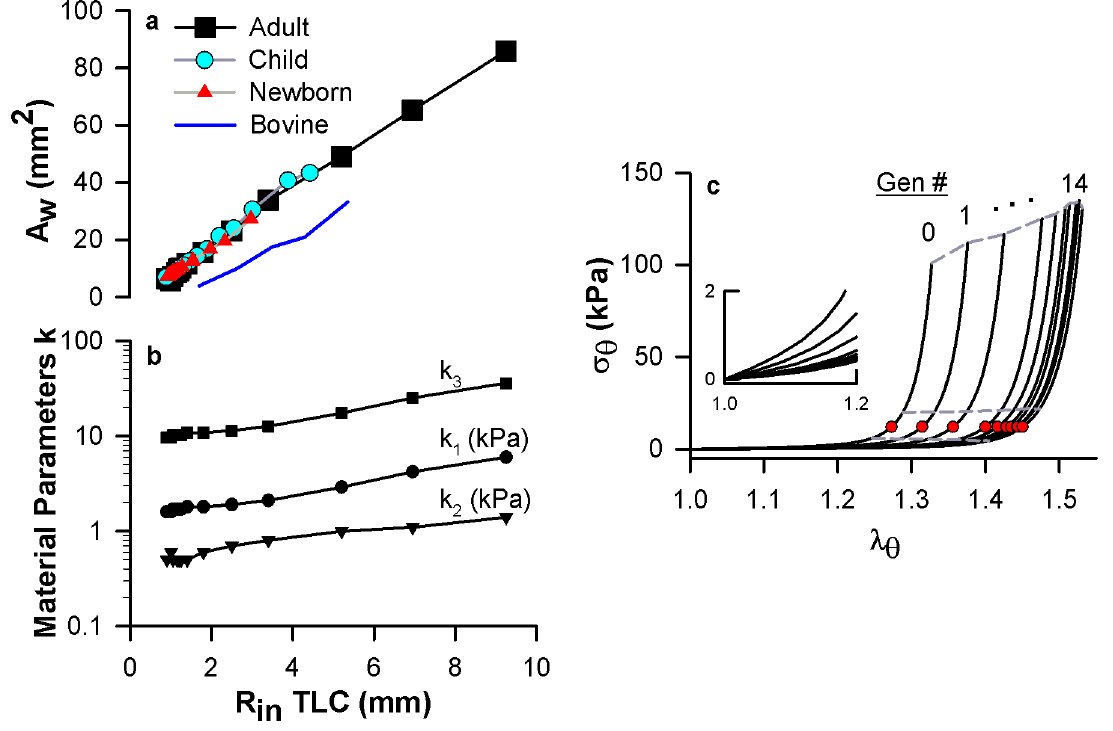
Figure 2. Mechanical homeostasis is maintained throughout the airway tree by a combined generation-dependence in wall dimensions and model-derived material parameters. a , Relationship between mean airway wall area (A w ) and mean luminal radius (R in TLC) for healthy humans obtained and reanalysed from the literature: newborns [15] (red triangles, 0 year old), children [15] (cyan circles, 3 years old), and adults [14] (black squares, mean age of 39.2 years old). The corresponding relationship for our bovine airways is shown in blue. Circles represent individual airway generations, where the largest radius in each data set corresponds to the trachea (generation 0). All dimensions are measured at total lung capacity (TLC, 2.5–3.0 kPa P TM ). b , The model-predicted relationship between the material parameters k 1 , k 2 , k 3 and the luminal radius at TLC (R in TLC). c , The model-predicted generation dependence in circumferential stress ( s h ) vs. circumferential stretch ratio ( l h ) from generation 0 to generation 14. Red circles are the corresponding stress-stretch at 0.75 kPa P TM . Dashed lines are the corresponding stress-stretch at 0.5, 1.0, and 3.0 kPa P TM . The inset is an enlargement of the range from 0 to 1.2 l h .